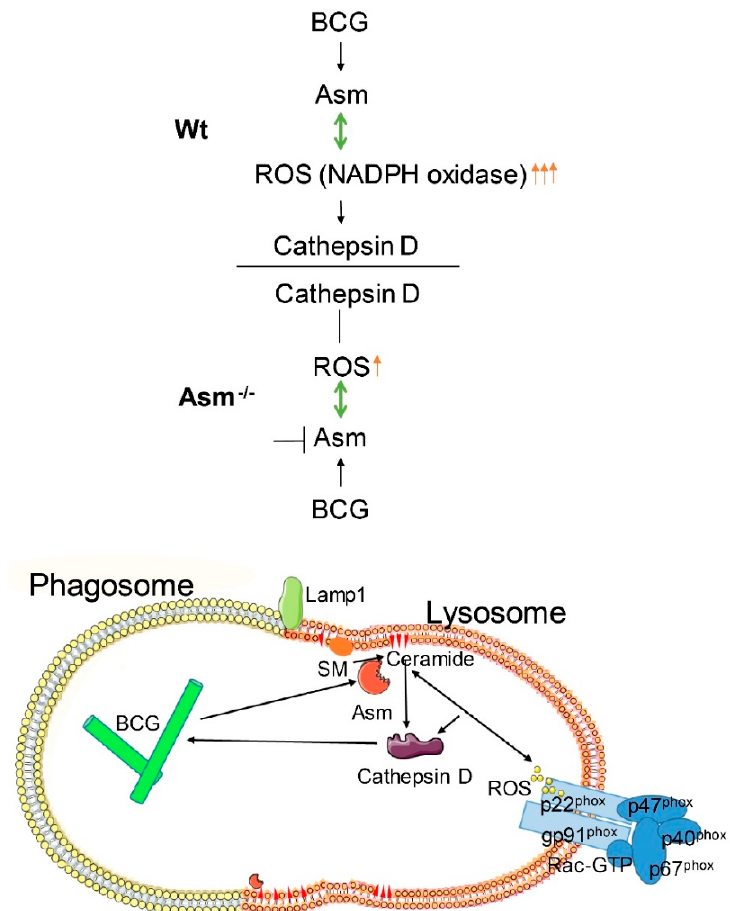
Figure 8. Model for Asm function in BCG infection. Infection of bone-marrow-derived macrophages (BMDMs) with Mycobacterium bovis Bacillus Calmette-Guérin (BCG) triggers activation of the acid sphingomyelinase (Asm)/ceramide system, which increase reactive oxygen species (ROS) via clustering of nicotinamide adenine dinucleotide phosphate (NADPH) oxidase subunit p47 phox . ROS promote BCG degradation by the lysosomal enzyme cathepsin D (CTSD). Macrophages of Asm-deficient mice abrogate these effects, and these mice are more susceptible to BCG infection than wild-type mice.